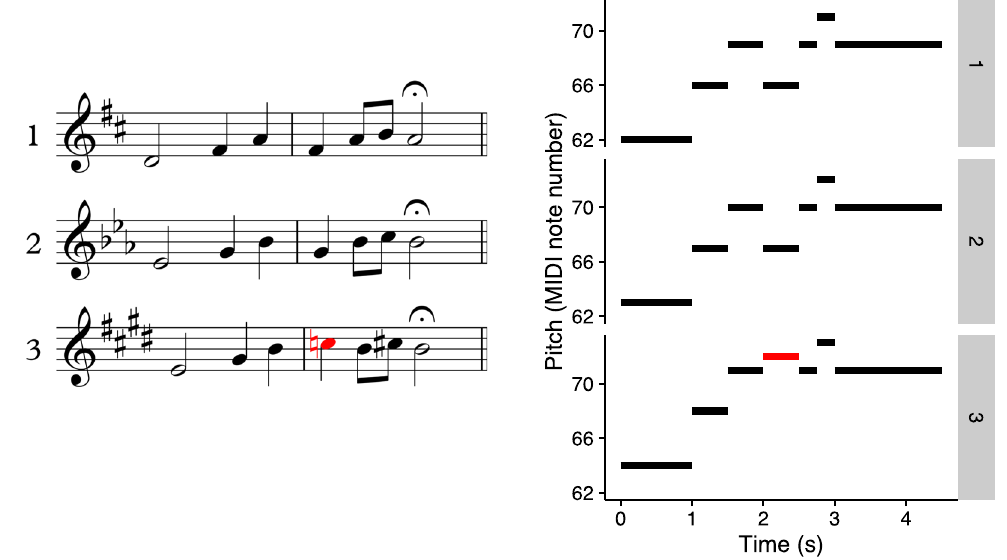
Figure 1. Example 3-AFC melodic discrimination item, in traditional music notation (left) and piano-roll representation (right). The third melody is the odd-one-out, and the altered note is